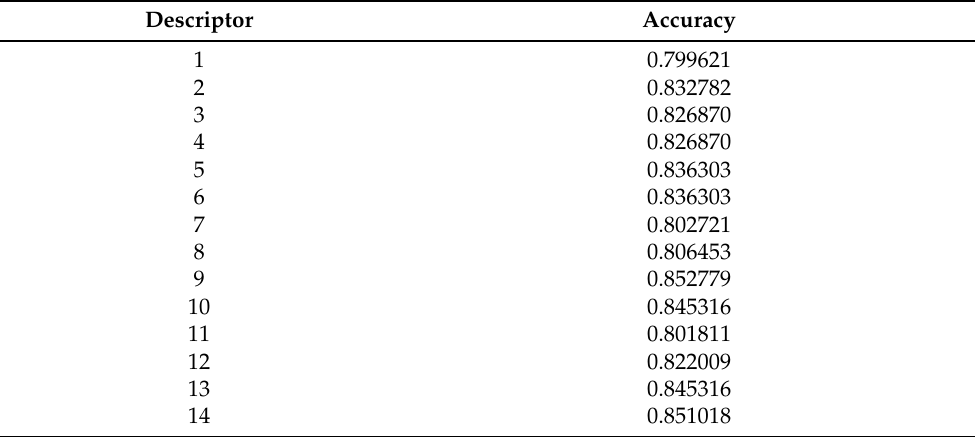
Table 4. SVM results using different combinations of the four features: local binary pattern (LBP), vegetation index (RGBVI, GLI,or NGRDI), average, and